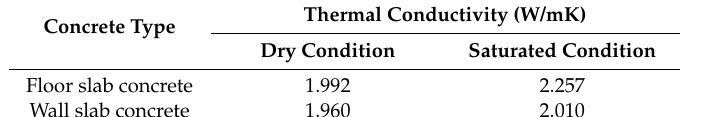
Table 3. Results of thermal conductivity measurement (concrete sample).